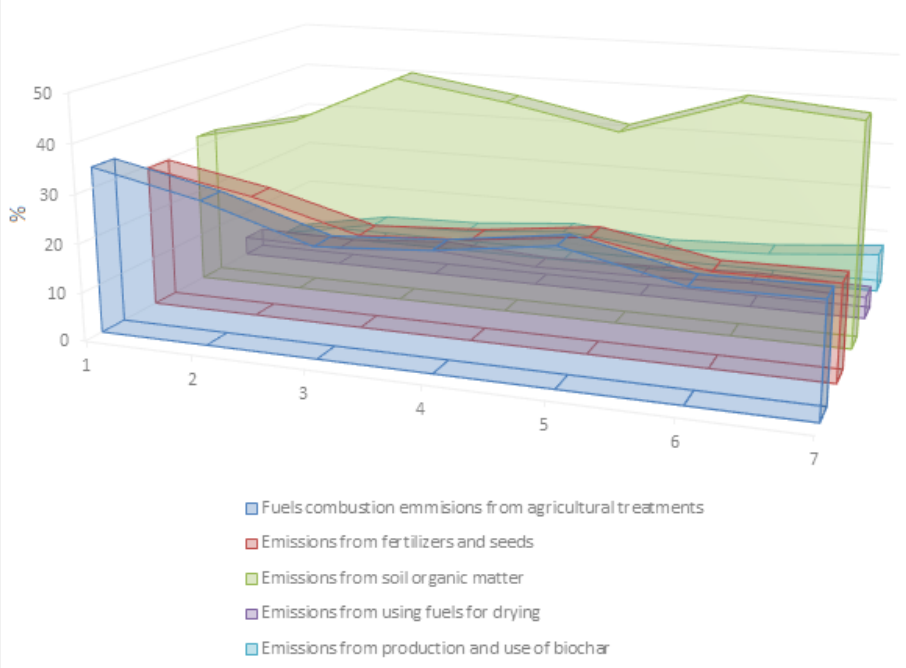
Figure 5. Share of individual emission sources in the total GHG emission related to soybean pro-